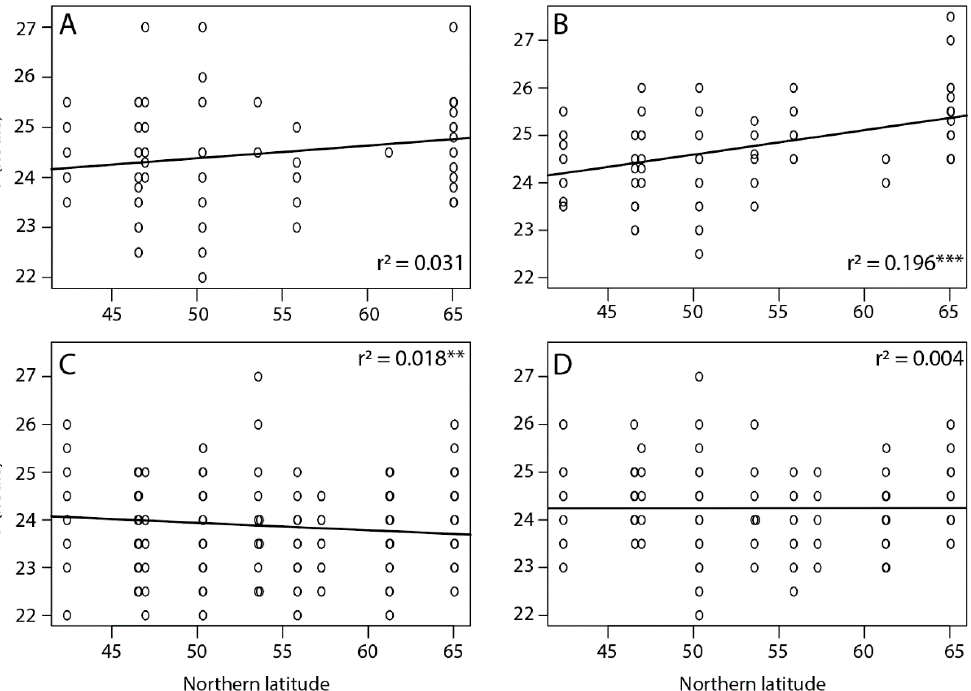
Figure 2. Free running period ( τ ) of ( A ) virgin males, ( B ) virgin females, ( C ) mated males, and ( D ) mated females in Nasonia vitripennis populations collected along a latitudinal gradient in Europe. Asterisks indicate a significant e ff ect of location along the cline (*** p < 0.001 and ** p < 0.05, linear mixed e ff ect model). E ff ect of sex: LRT = 2.22, p = 0.13; e ff ect of mating status: LRT = 44.32, p < 0.01; e ff ect of location: LRT = 38.38, p < 0.01; e ff ect of location for virgin females LRT = 14.56, p < 0.05 and for mated males LRT = 13.02, p <